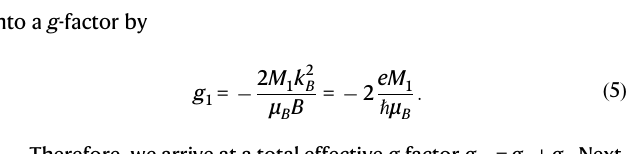
Fig. 5 | Tunable effective g -factors. a Evolution of the energy bands (CB, HH, and LH)asafunctionofthe SLperiod( t period = t InAsSb + t InSb =1.6 t InAsSb ),calculated using thebandparametersextractedfromtheexperiment. b Evolutionoftheeffective g - factors for the CB, extracted using two different methods, as a function of t InAsSb . The error bars are determined by varying the Kane energy E p , as explained in the Supplementary Note 5. Red circles label out the three SL samples measured in this